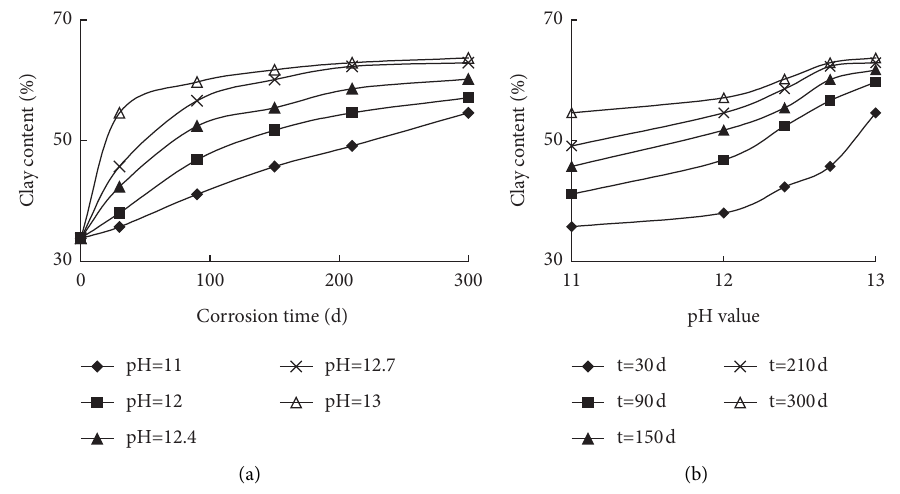
Figure 10: Variation in the clay particle content.